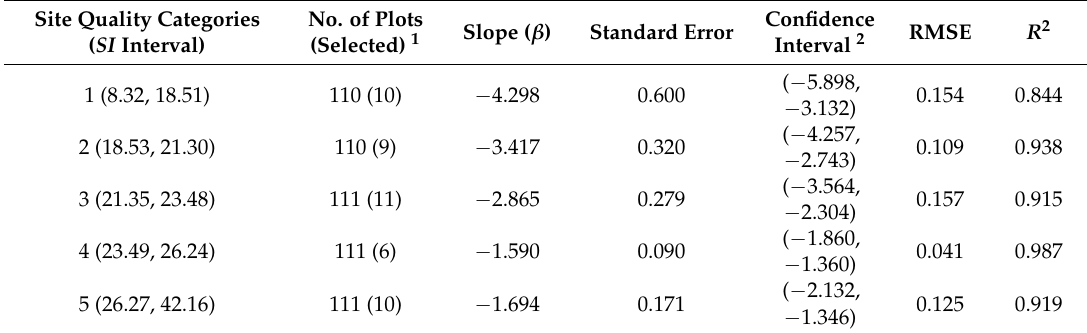
Table 2. Comparison of the slope coefficients of the maximum size-density line between the 5 different site quality categories (based on site index) and the relevant fitting